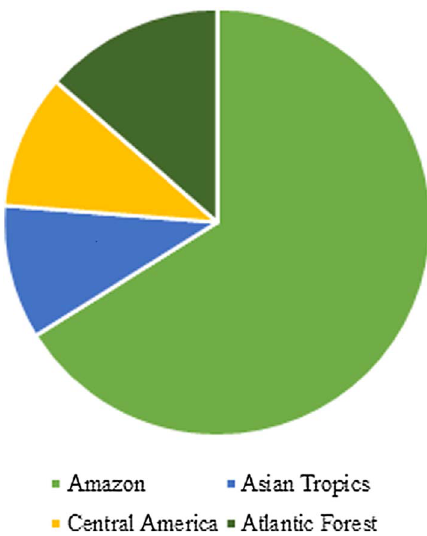
Figure 2. Biogeographic precedence of plant material in the reviewed papers.